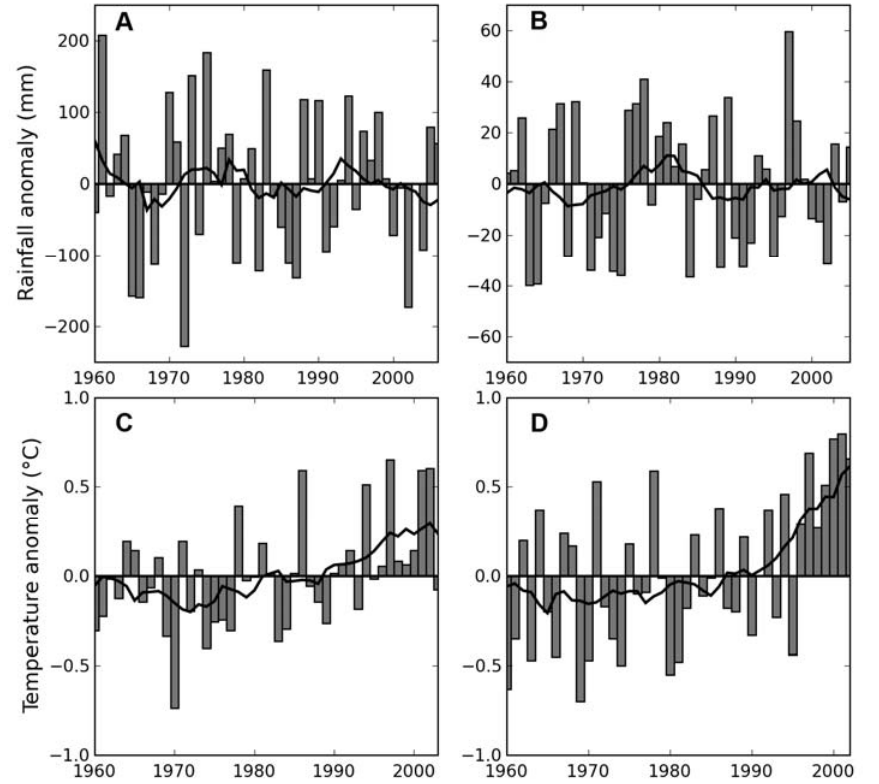
Figure 7. 1960–2005 all-India rainfall and temperature anomalies for kharif (A, C) and rabi seasons (B, D) [25]. Kharif season has mean annual rainfall of 911 mm and mean annual temperature of 27.09 °C. Rabi season has mean annual rainfall of 161 mm and mean annual temperature of 22.48 °C. The black line represents the 11-year moving